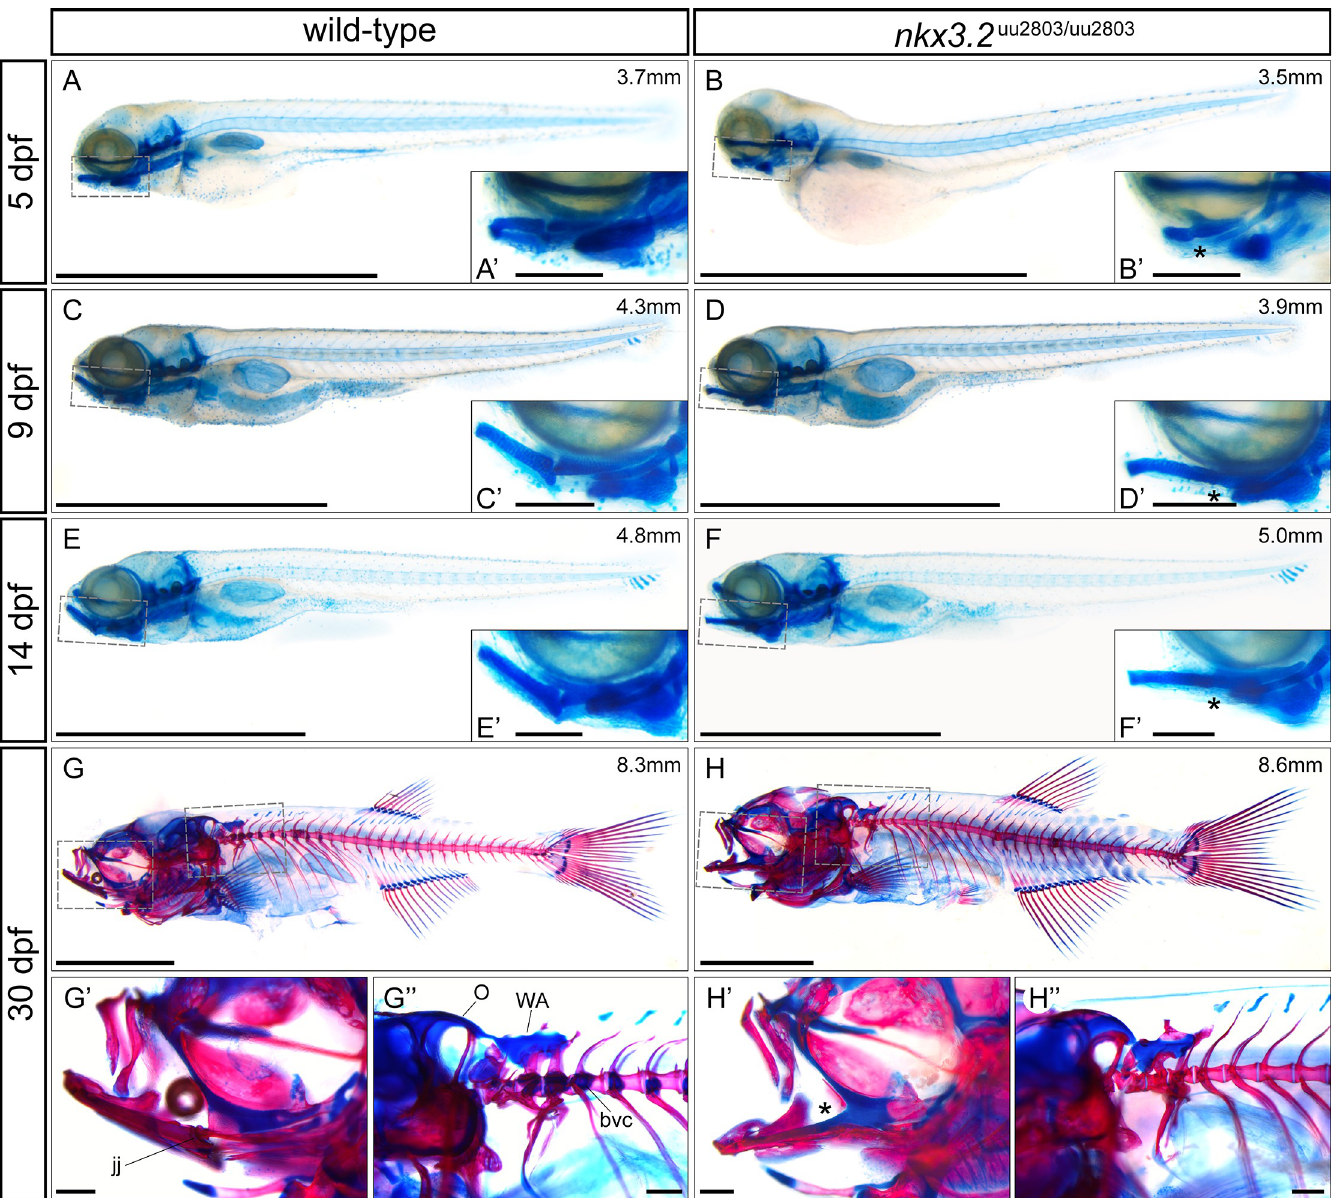
Fig 5. Skeletal staining of wild-type and nkx3 . 2 uu2803/uu2803 zebrafish. ( A-F ) lateral views of cartilage-stained wild-types and nkx3 . 2 mutants at 5, 9 and 14 dpf. ( G-H ) lateral views of cartilage- and bone-stained wild-types and nkx3 . 2 mutants at 30 dpf. Boxes in ( A-H ) indicate the zoomed-in regions in the insets or zoomed-in panels ( G’ , G” , H’ , H” ). The measurements in mm refer to standard length (SL). Asterisks indicate the fusion between Meckel’s cartilage and palatoquadrate in the jaw joint. jj– jaw joint, O–occipital region, bvc–basiventral cartilage, WA–Weberian apparatus. Scale bars: 2mm ( A - H ), 200 μ m ( A’-H’ and G”-H”